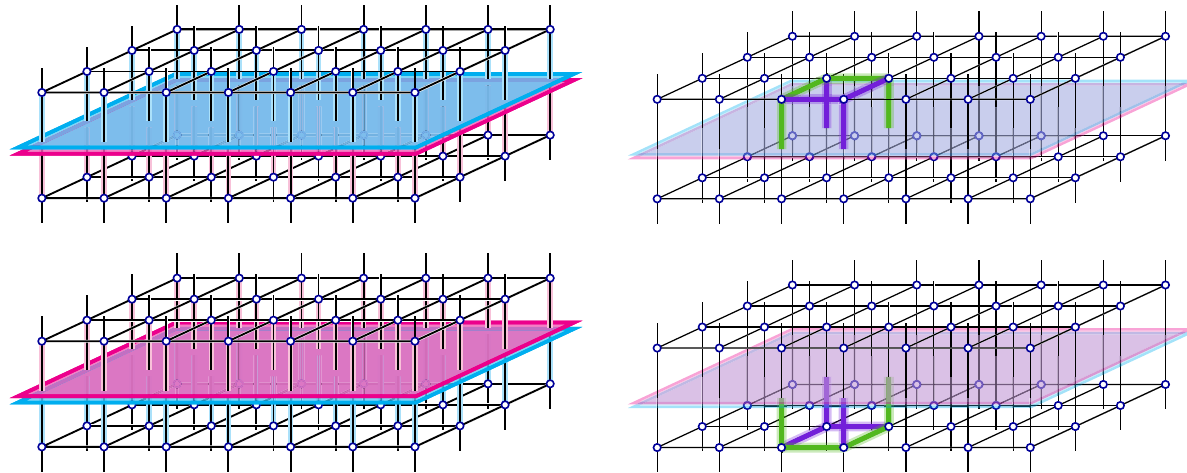
FIG. 20. Portals in the six-ring fusion network. Right: the modified fusion pattern to create a portal pair between two topological disks. The qubits (belonging to resource states) on either side of each portal are fused with the qubits on the corresponding side of the other portal (i.e., qubits of like colors are fused; pink is fused with pink and teal is fused with teal). Right: an example of a check operator spanning the portals.